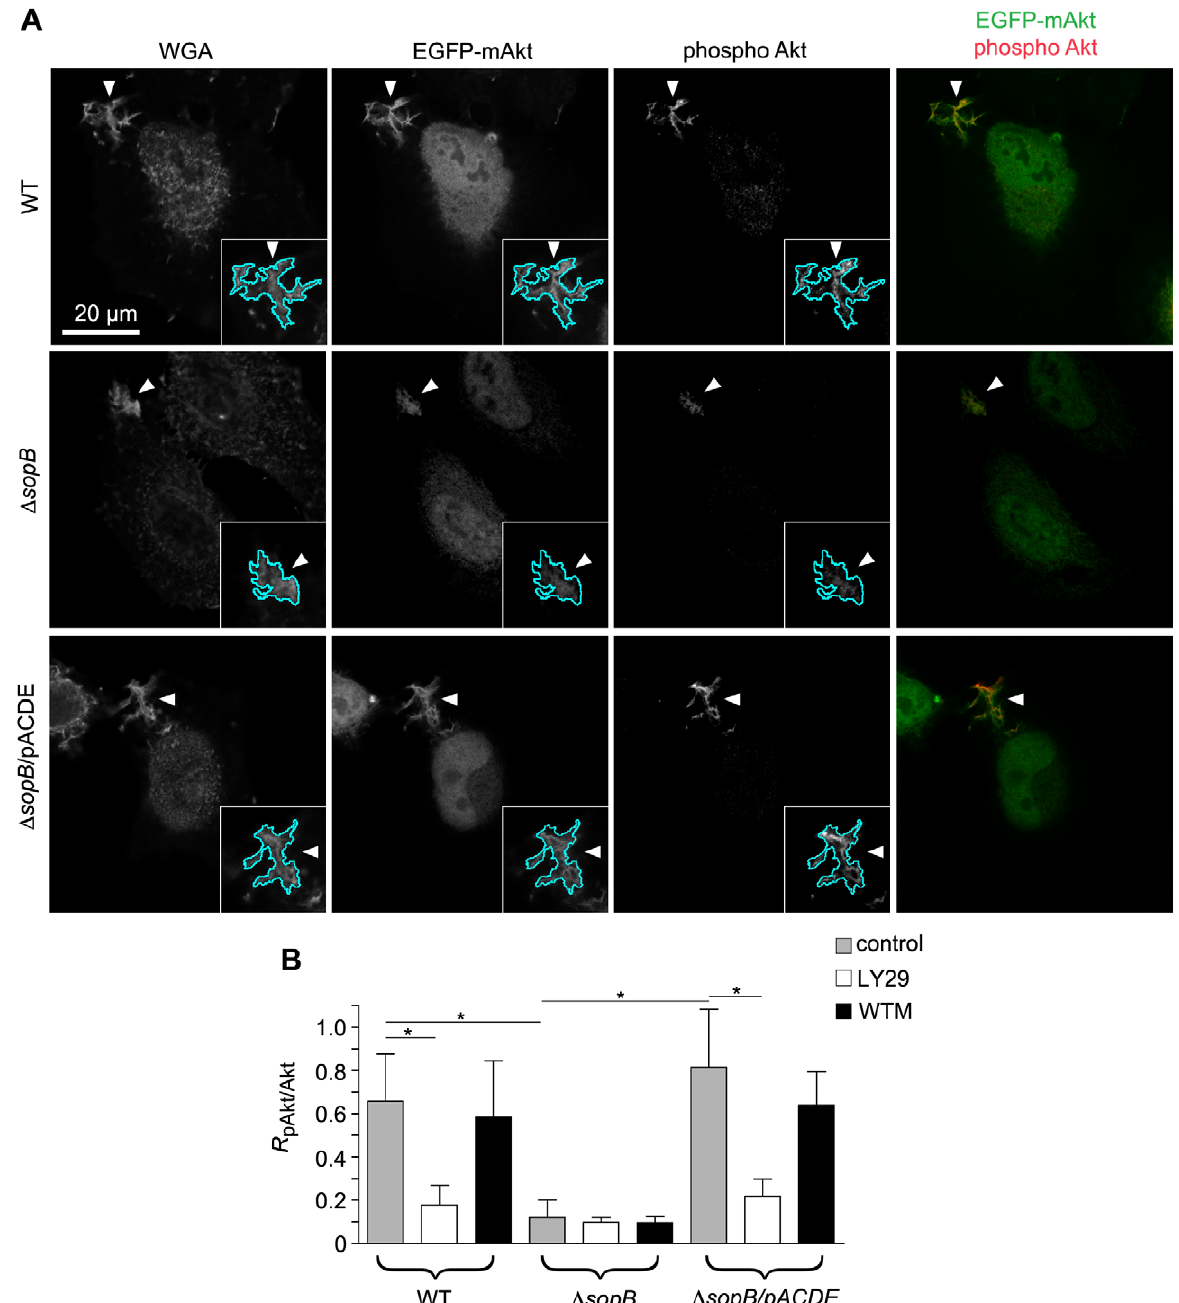
Figure 5. Akt regulators accumulate in Salmonella induced ruffles. HeLa cells were transfected with plasmids encoding epitope-tagged proteins as indicated. After 20 hr they were infected with Salmonella for 30 min, then fixed and processed for immunofluorescence microscopy. GFP- HA-Akt transfected cells were stained for Salmonella LPS (Cy5) and phospho Akt Ser473 (AF568: A–C), Myc (AF568: D–F) or 3 6 FLAG (AF568: J–L). Cells expressing PDK1-Myc (G–I) were stained for LPS (Cy5), Myc (AF488) and actin filaments (phalloidin-AF568) to reveal the ruffles.